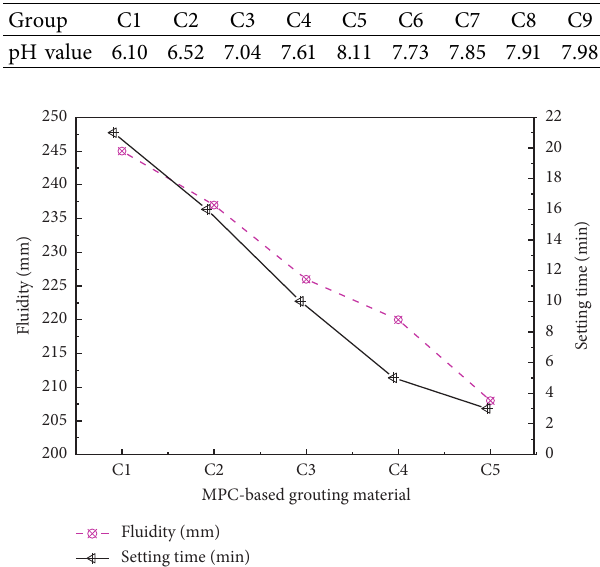
Figure 4: The fluidity and setting time of the fresh MPC-based grouting material with different additions of GGBS.